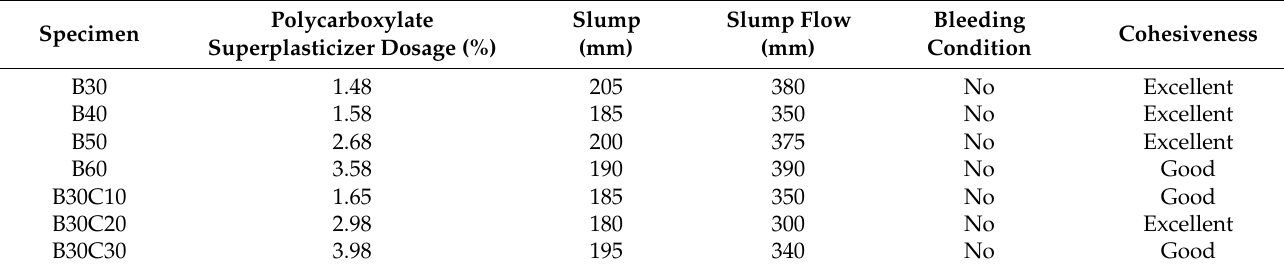
Table 6. Workability of plastic concrete.